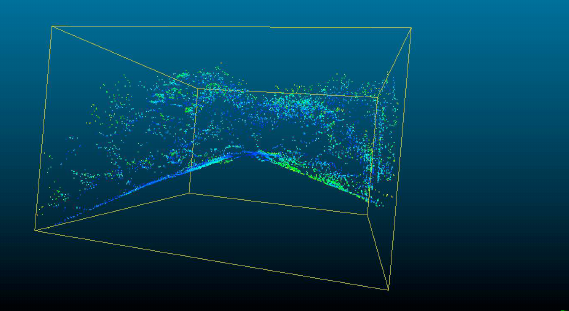
Figure 10. The point cloud after the removal of points with roughness values within 1 σ in the point cloud.